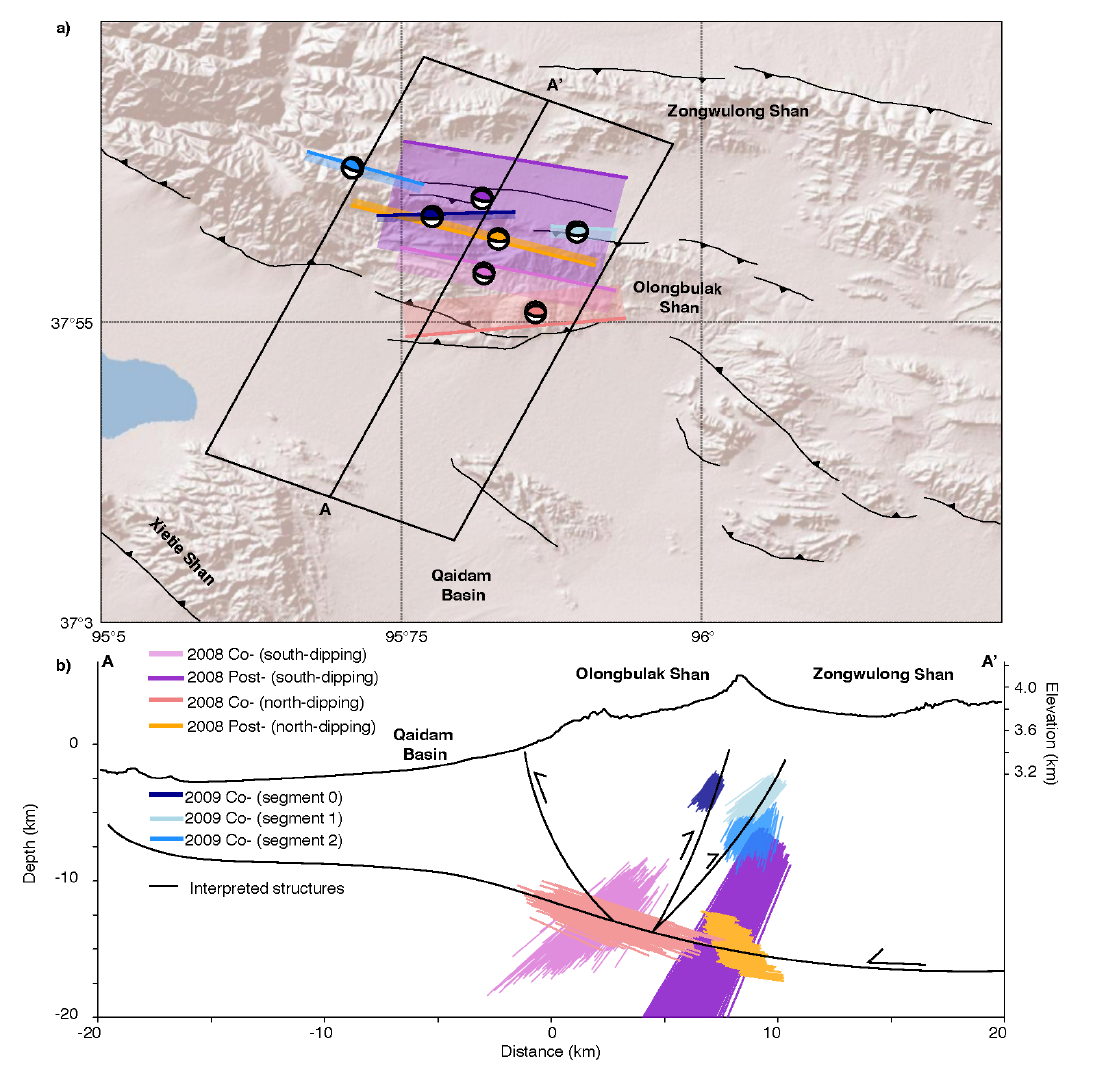
Figure 5. Posterior models for the 10 November 2008 and 28 August 2009 earthquakes and their post-seismic deformation from optimisations obtained with fixed dip directions. ( a ) Best-fitting posterior geometries in map view for the 2008 north-dipping co-seismic (coral red), the 2008 north-dipping post-seismic (orange), the 2008 south-dipping co-seismic (pink), the 2008 south-dipping post-seismic (magenta), and for the three segments of the 2009 co-seismic (dark blue, cyan, blue) fault inferences. ( b ) As for top figure, but along the N22 ◦ E profile perpendicular to the Olongbulak Shan marked A-A’ in ( a ) and with interpreted fault geometry in the middle/upper crust. Based on the coplanarity of the 2008 co- and post-seismic slip, we interpret that the 2008 earthquake ruptured a 32 ◦ north-dipping plane at 12 km depth rooting below the Olongbulak Shan and that the after-slip was mainly down-dip of the rupture plane. The 2009 earthquake broke three distinct 55–75 ◦ high-angle south-dipping back-thrust segments of the Olongbulak pop-up